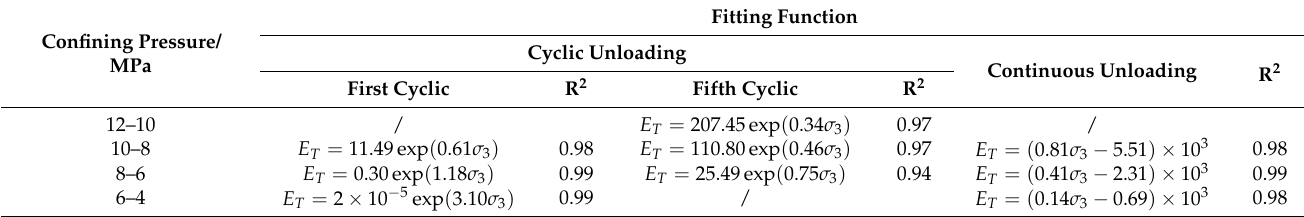
Figure 11. Tangential modulus of tectonic coal under different unloading path: ( a ) B-1 and C-1; ( b ) B-2 and C-2. Table 5. Fitting relationship between tangent modulus and confining pressure.